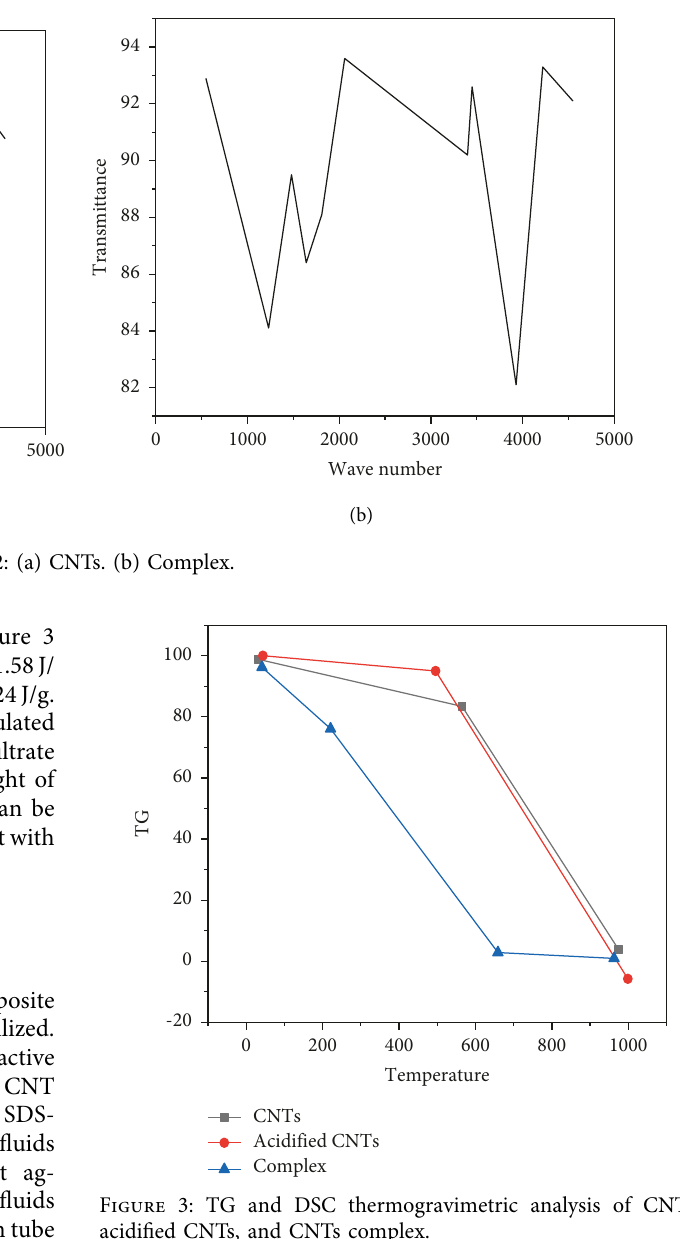
Figure 3: TG and DSC thermogravimetric analysis of CNTs, acidified CNTs, and CNTs